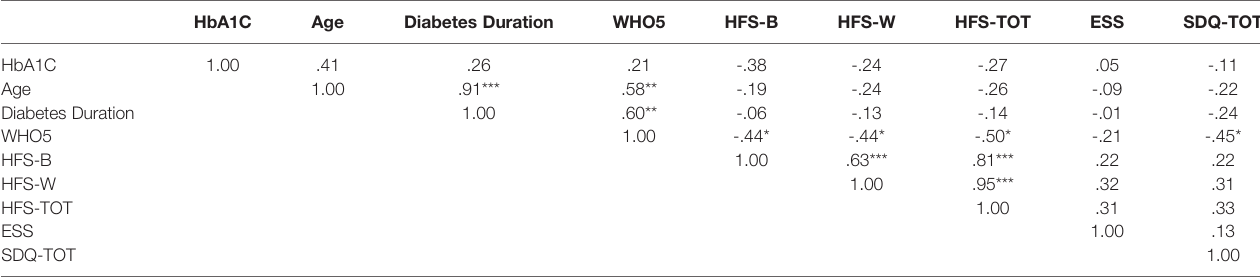
TABLE 2 | Spearman rho Correlation between Parental Well-being, HbA1C, Child Age, Diabetes duration, Hypoglycemia Fear, Child Behavior and Sleepiness (N=23). HbA1C Age Diabetes Duration